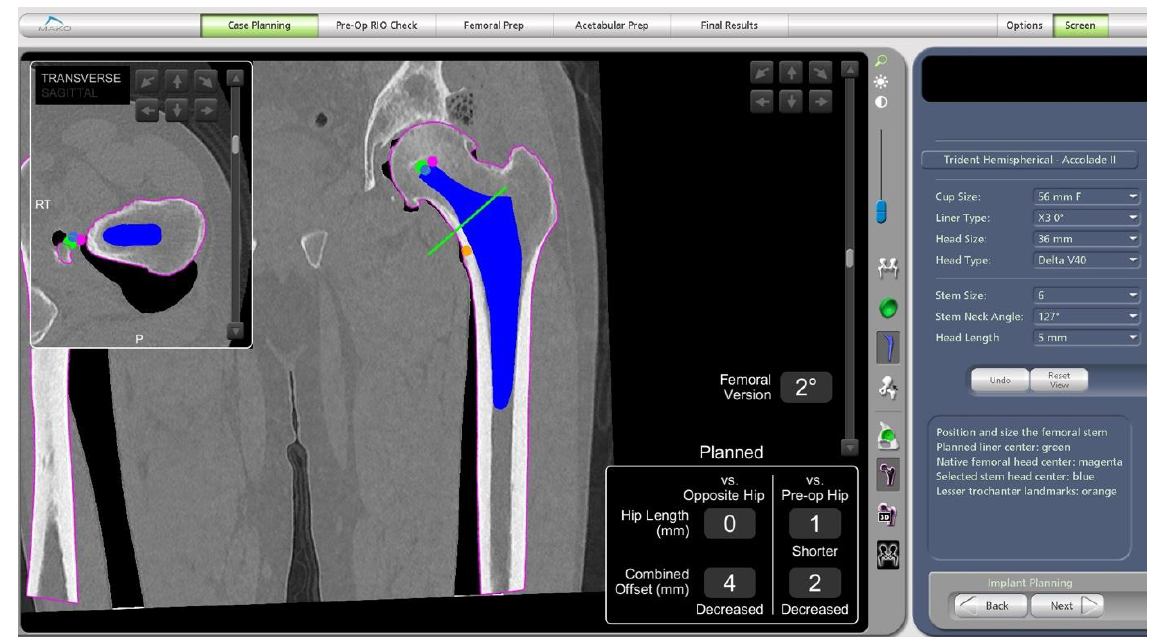
Figure 4. Preoperative screenshot showing planned femoral osteotomy with green line, femoral centre of rotation with green dot at tip of implant, planned leg length and combined offset changes at bottom right of screen and calculated femoral version just above.